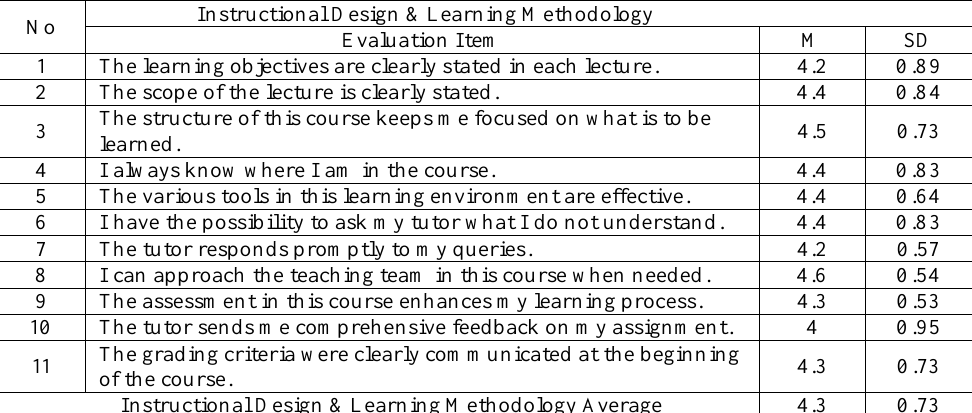
Descriptive Results of Instructional Design and Learning Methodology